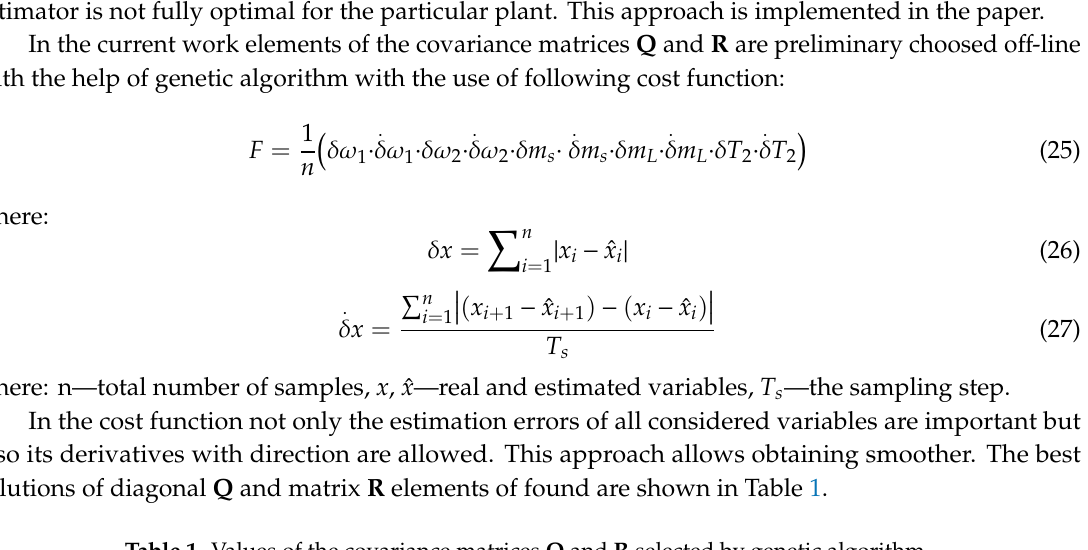
Table 1. Values of the covariance matrices Q and R selected by genetic